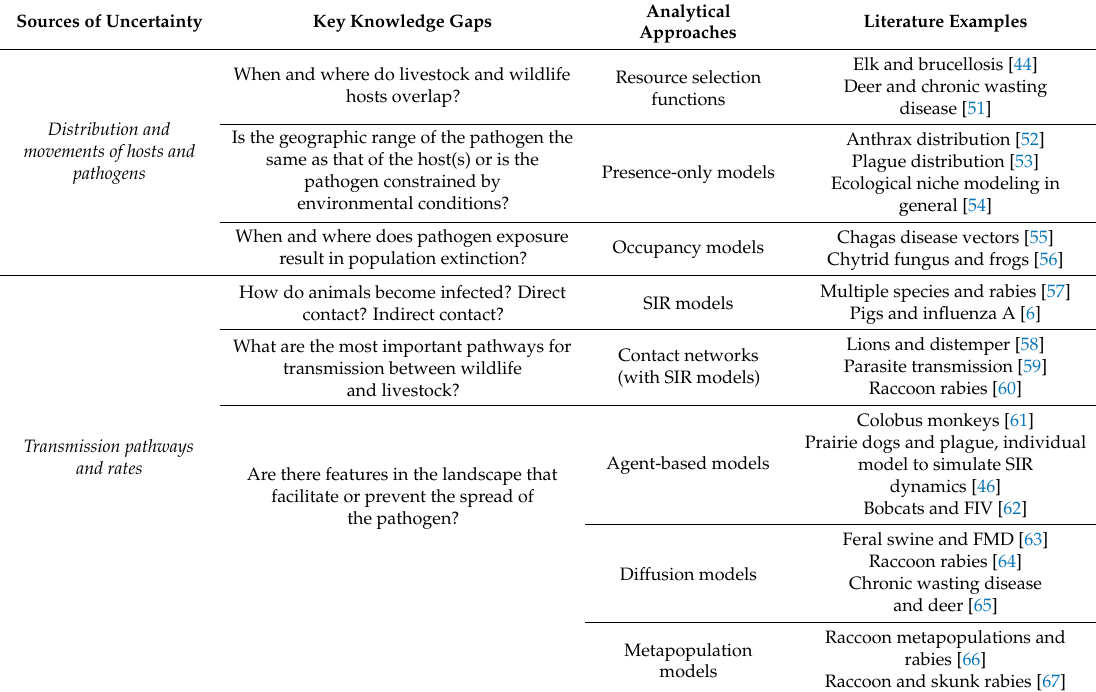
Table 1. Three central sources of uncertainty and outstanding questions (‘knowledge gaps’) encountered when considering mathematical models of disease transmission at the livestock-wildlife